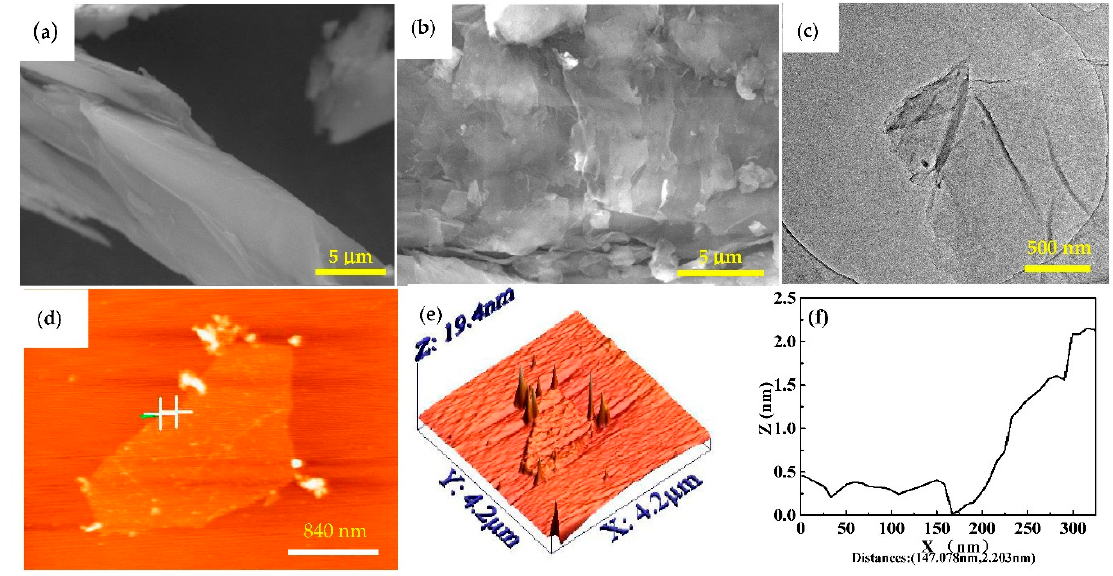
Figure 3. Scanning electron microscopy (SEM) images of ( a ) Flake graphite and ( b ) Graphene oxide (GO); ( c ) Transmission electron microscopy (TEM) and ( d ) Atomic Force microscopy (AFM) images of GO; ( e ) 3D image of surface image; ( f ) cross-section analysis of the height of graphene using AFM.